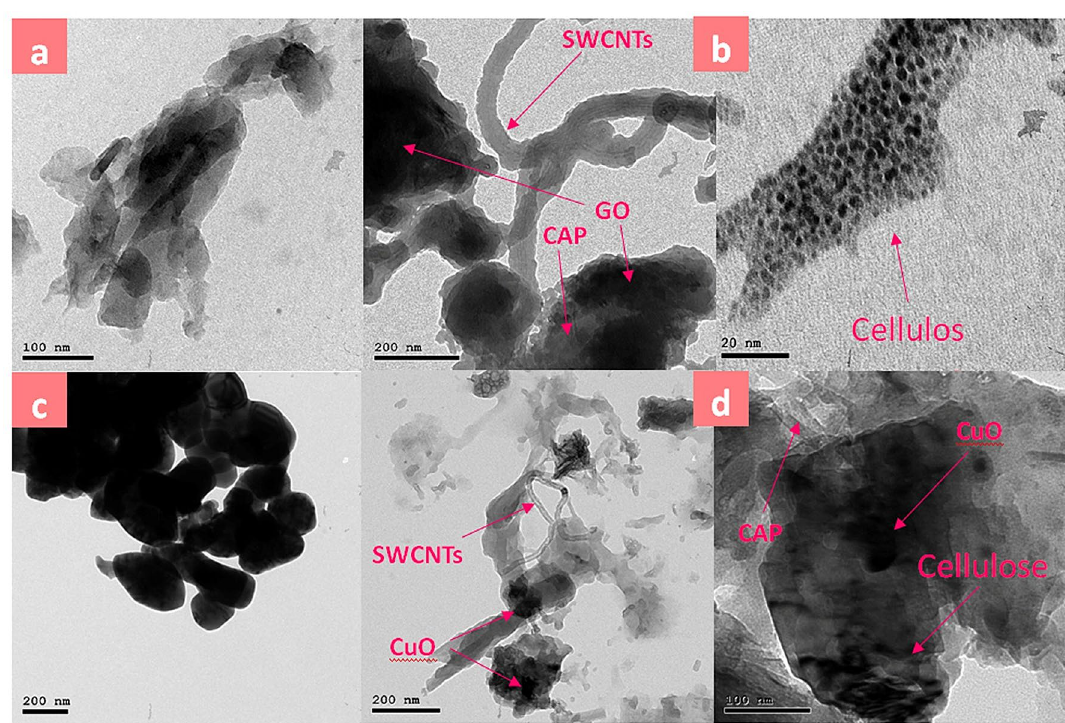
Figure 3. TEM images of CPA ( a ), CPA/N-SWCNTs-GO-CE ( b ), CuO ( c ), and CPA/N-SWCNTs-GO-CE/CuO nanocomposites ( d